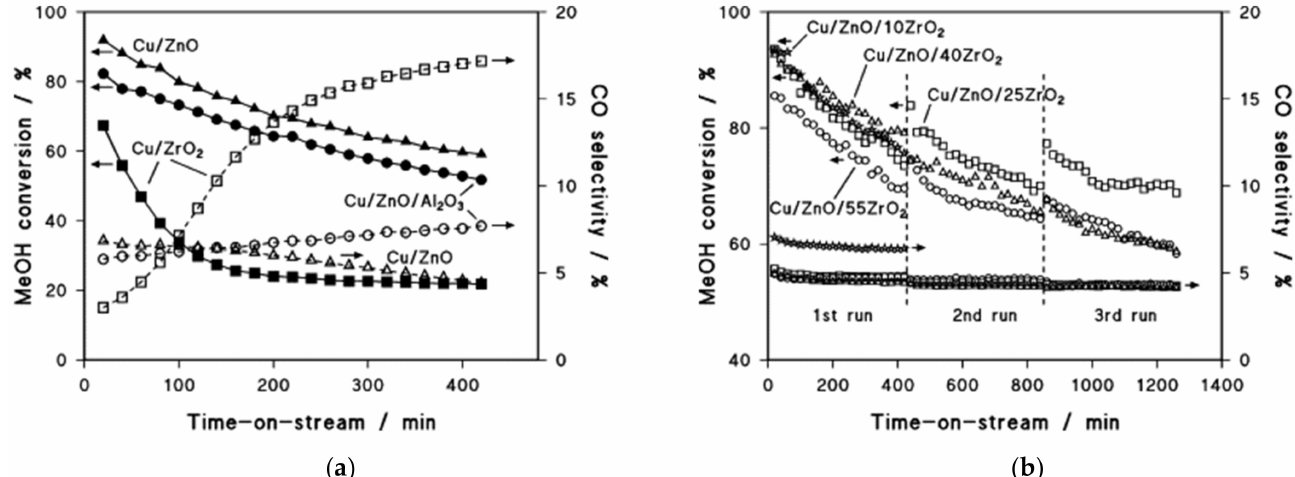
Figure 7. ( a ) Catalytic activity of Cu-based catalysts in the SRM reaction at 400 ◦ C. Experimental conditions and symbolism: (F/W, 1.6 dm 3 min − 1 g − 1 ), (Circle symbols, Cu/ZnO/Al 2 O 3 ; triangle, Cu/ZnO; square, Cu/ZrO 2 ); ( b ) Catalytic activity of Cu/ZnO/ZrO 2 in the SRM reaction at 400 ◦ C. Experimental conditions and symbolism: (F/W, 1.6 dm 3 min − 1 g − 1 ), (Star symbols Cu/ZnO/10ZrO 2 ; square, Cu/ZnO/25ZrO 2 ; triangle, Cu/ZnO/40ZrO 2 ; circle, Cu/ZnO/55ZrO 2 ). (Adapted from [85], copyright 2009, Elsevier.)